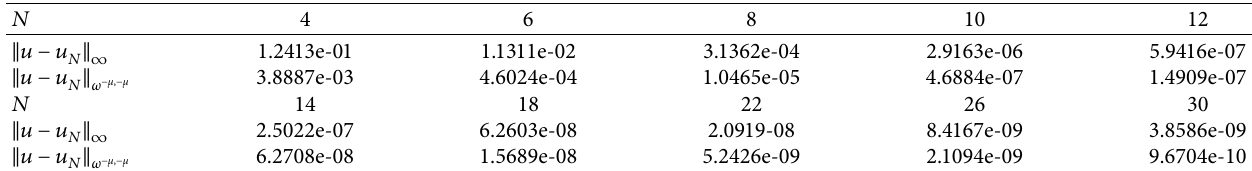
and L 2 errors for Example ω − μ , − μ ∞ and L ω errors for Example 2. − μ , − μ ∞